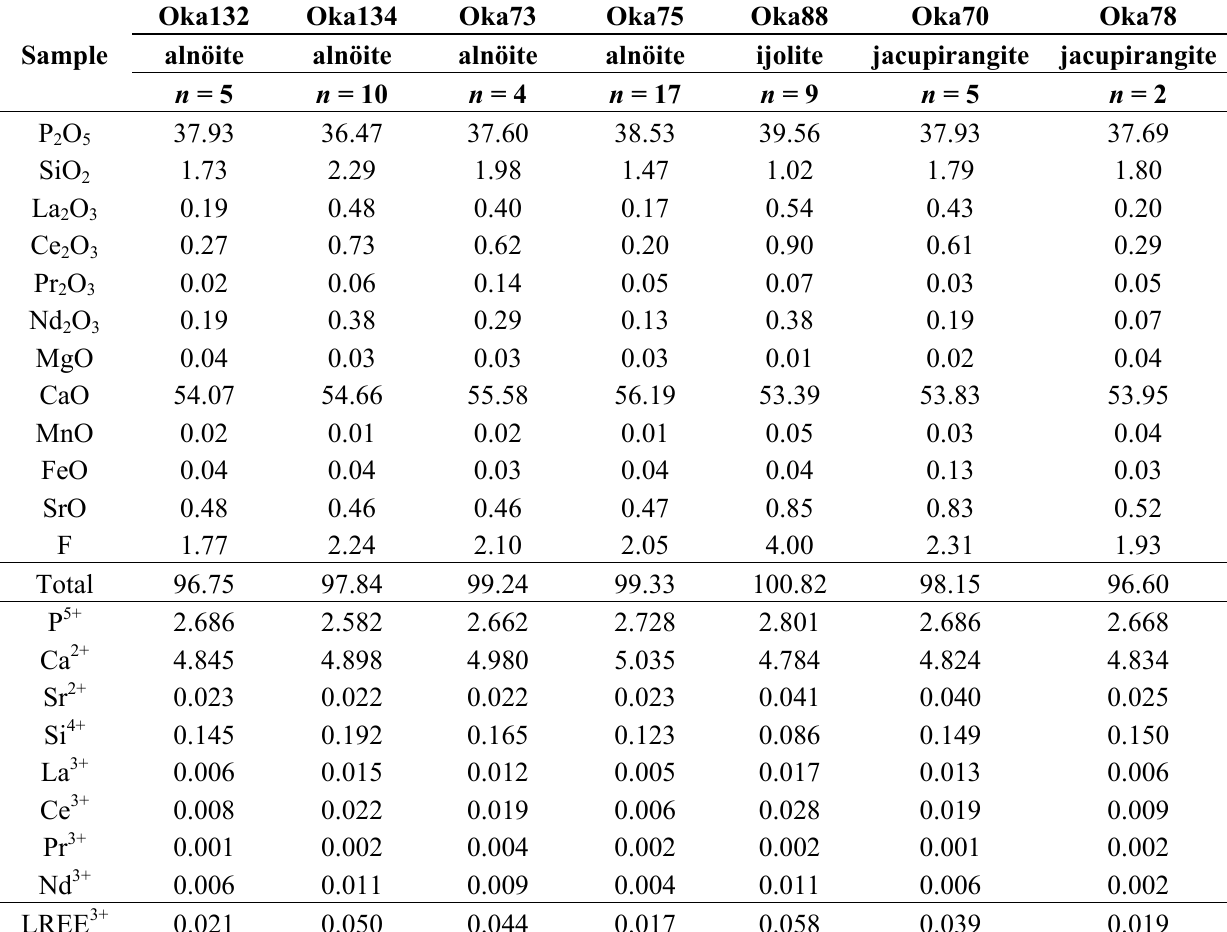
Table 4. Major element abundances of apatite from ijolite, alnöite and